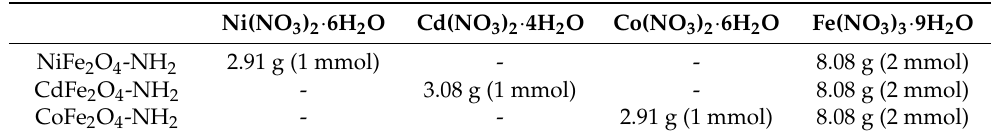
Table 3. Amounts of the respective transition metal nitrates dissolved in the reaction media for the synthesis of the NH 2 -functionalized ferrite